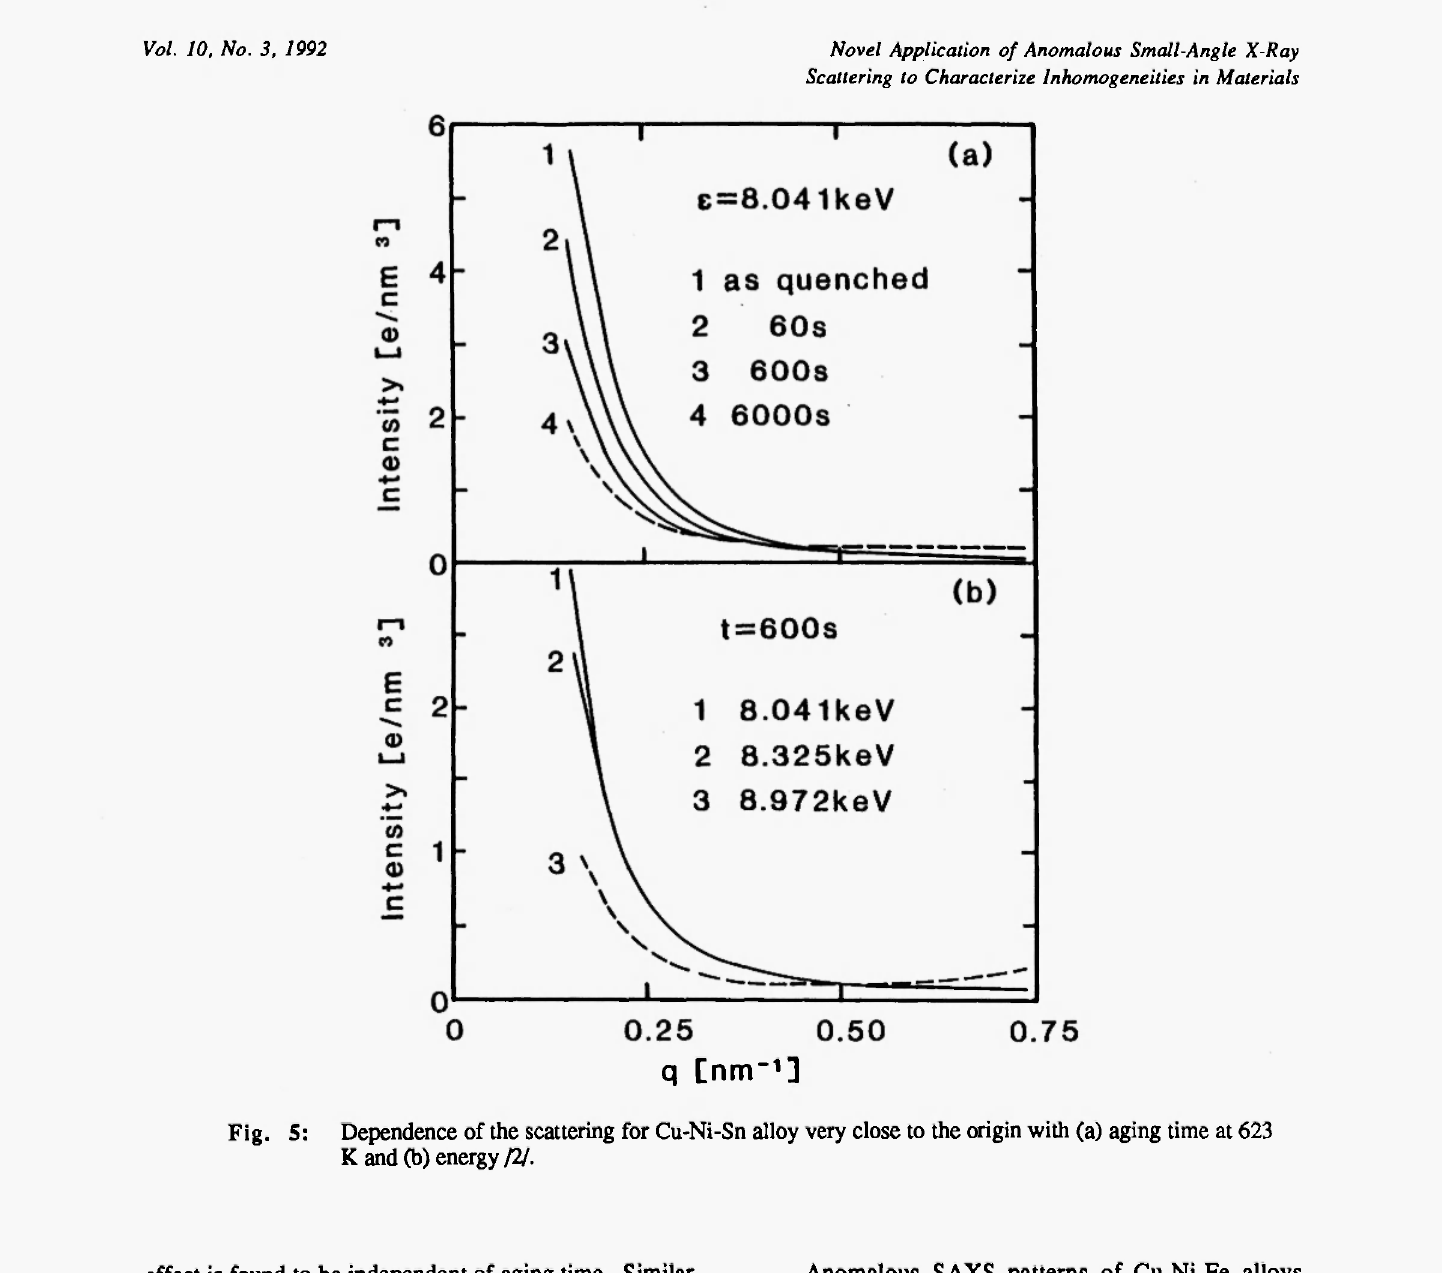
Fig. 5: Dependence of the scattering for Cu-Ni-Sn alloy very close to the origin with (a) aging time at 623 Κ and (b) energy